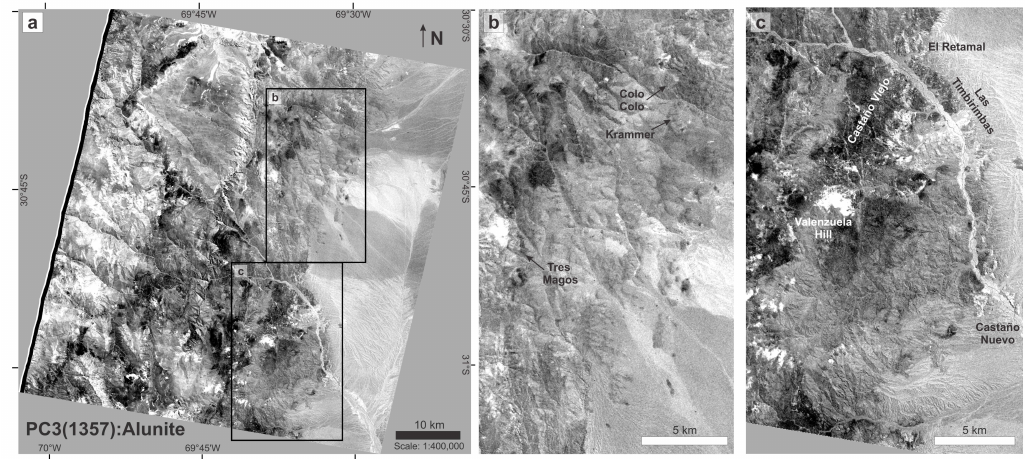
Figure 15. ( a ) Principal component 3 for bands 1, 3, 5 and 7 (alunite). White zones represent areas where it is more likely to find alunite. The only hydrothermal alteration zones related to known ore deposits, which probably contain alunite based on dense clusters of white pixels, are Tres Magos ( b ), and Valenzuela Hill ( c